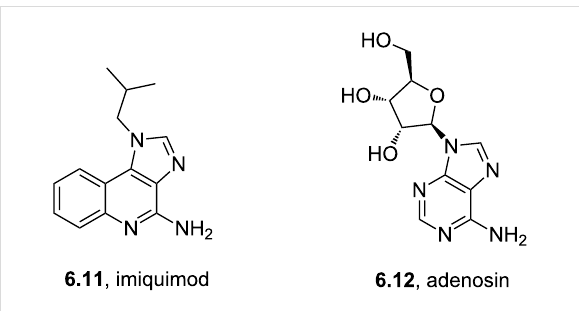
Figure 17: Structural comparison between imiquimod and the related adenosine nucleoside.